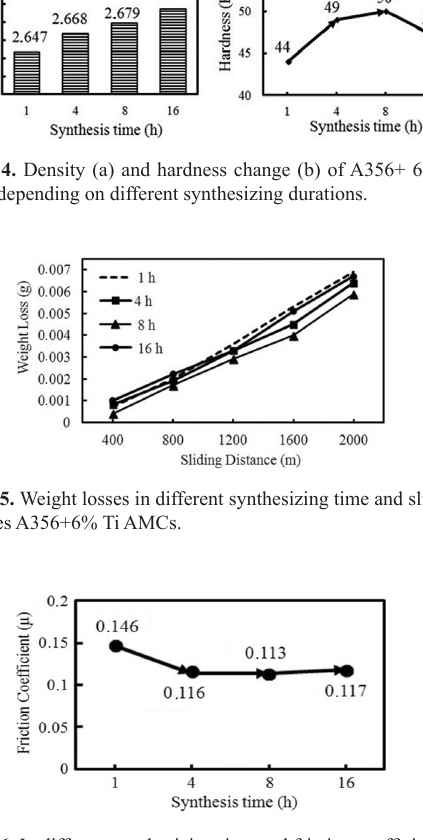
Figure 6. In different synthesizing time and friction coefficient of the A356+6% Ti Table 2. Wear rates in different synthesizing time and sliding distances A356+6% Ti AMCs. Synthesizing Time (h)